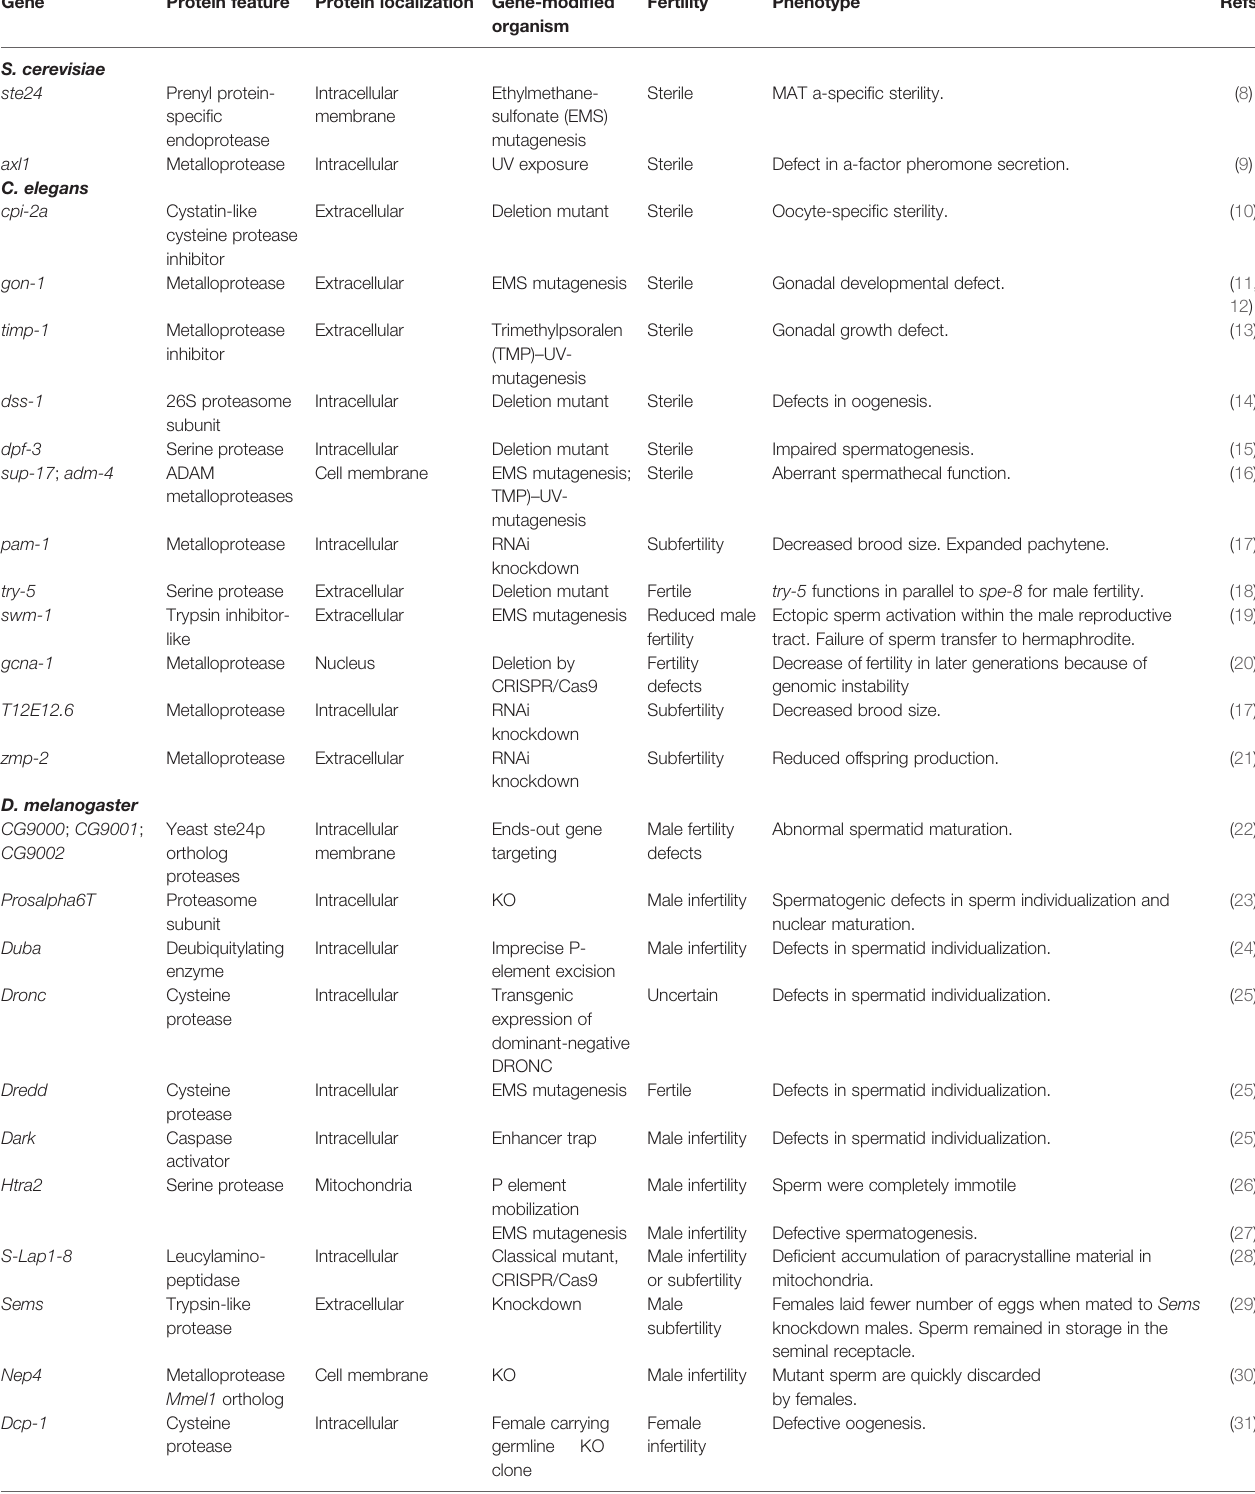
TABLE 1 | Proteolysis-related genes associated with reproduction. Gene Protein feature Protein localization Gene-modi fi ed